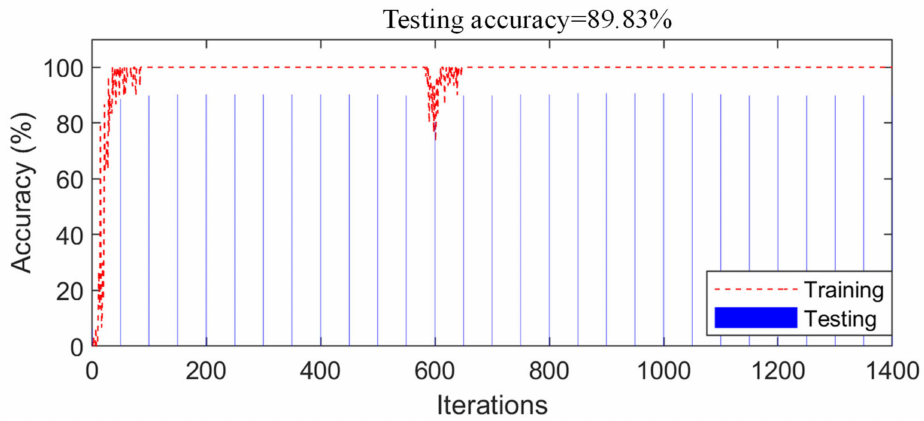
Figure 12. Detection results of the control experiment (numerical bridge model). Table 3. Comparisons of the detection results before and after the decision-level fusion. Accuracy Decision-Level Fusion